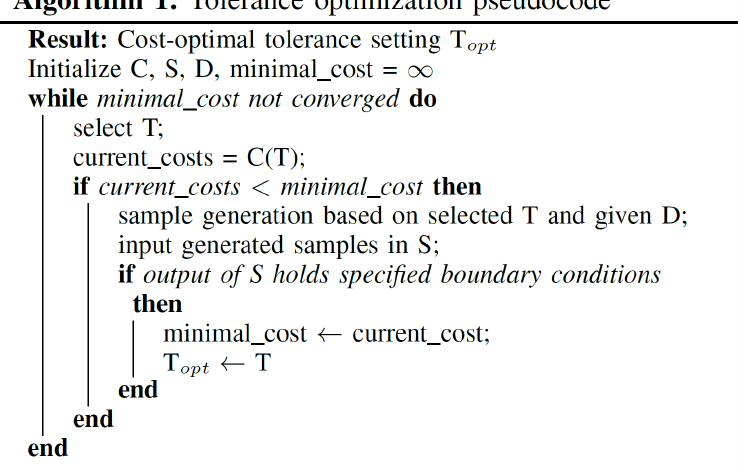
Figure 5. Pseudocode of the implementation of the cost-driven statistical tolerance synthesis.